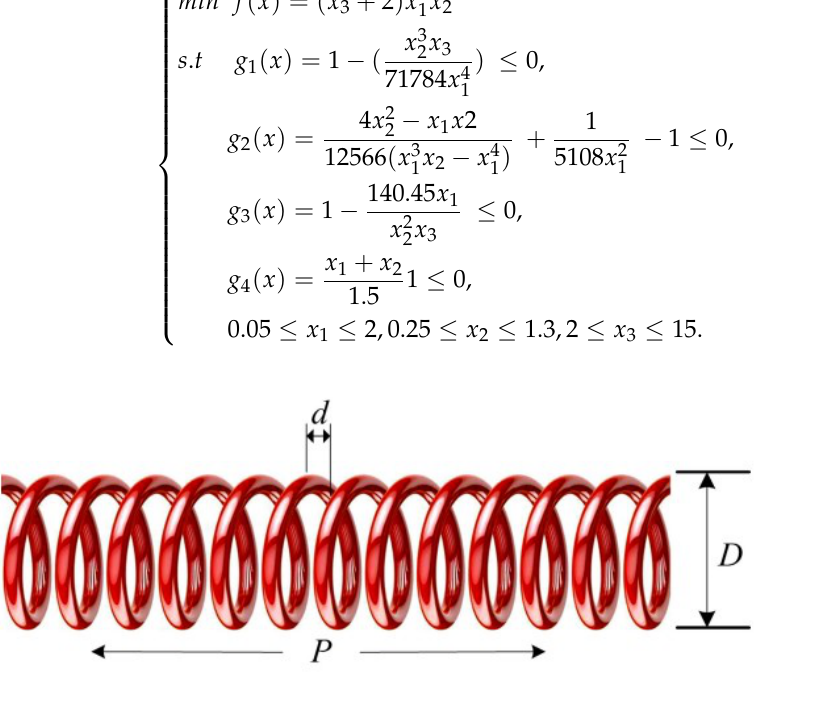
Figure 8. Design of pressure springs.